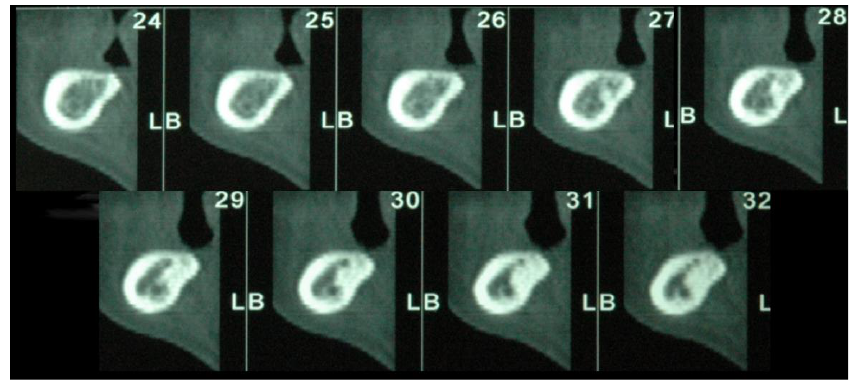
Figure 2. Preoperative CT scan of #45 – 47 region: an ill-defined radiopacity is visible, which could be due to the presence of a root fragment left in the alveolus at the time of extraction of #46. Several hours after the intervention and on subsequent days, the patient spontaneously reported continuous pain of a pulsating type, similar to pulpits pain, close to the right mandibular molar area. The authors made the diagnosis of IPL after intraoral radiographic examination. The IPL was relieved only through administration of an analgesic (nimesulide 100 mg—Aulin, Roche, Milan, Italy), but no neurosensory changes were reported for the right